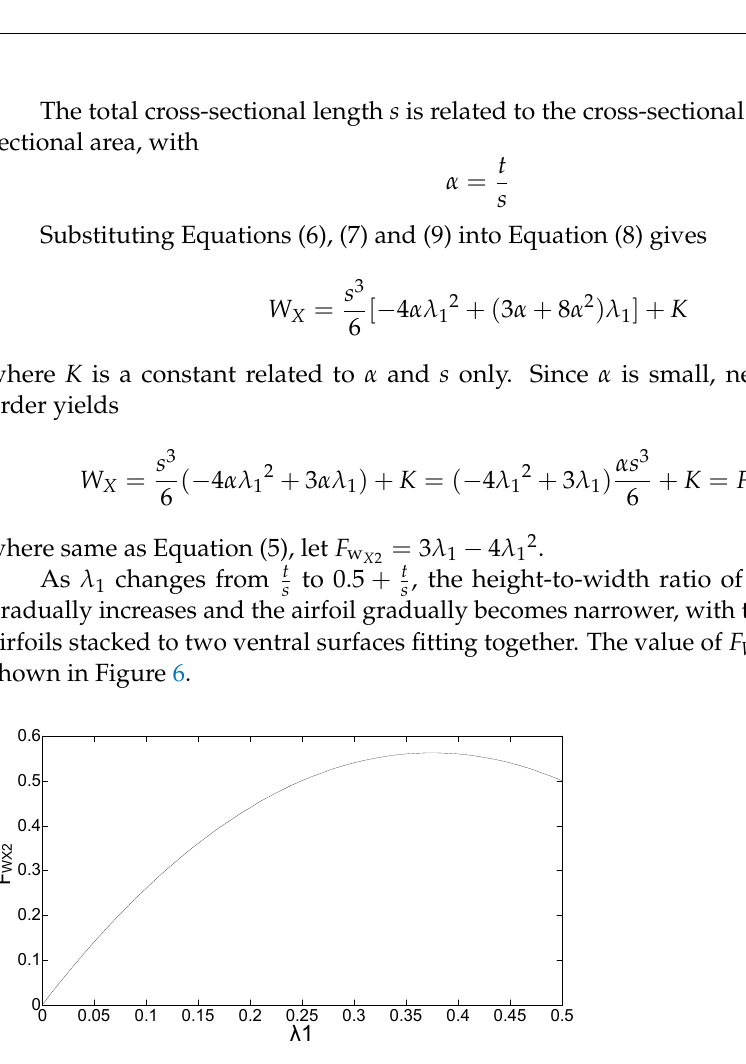
λ and λ 1 . F X 2 and 1 .